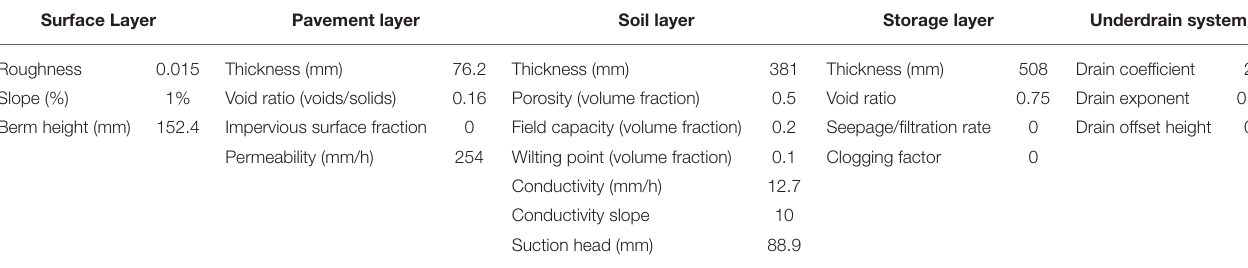
TABLE 1 | SWMM parameter values used for modeling PP.